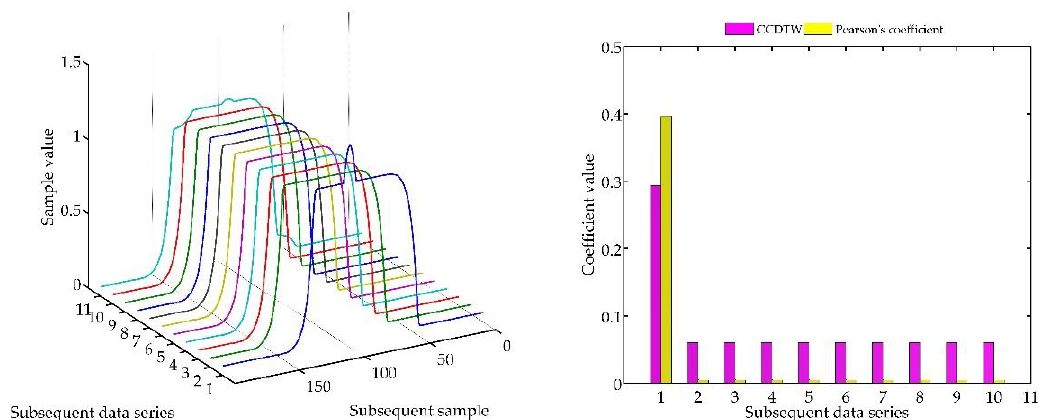
Figure 15. Simulation results achieved for data shifted by − 15 samples for the first series (blue line) for r ampl = 2.